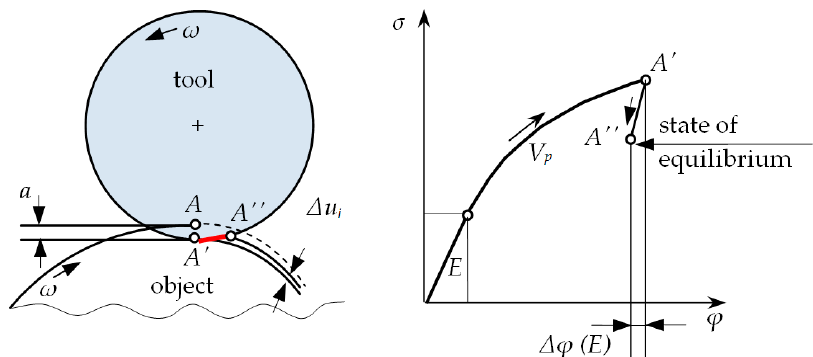
Figure 2. Elastic recovery during the roller burnishing process.